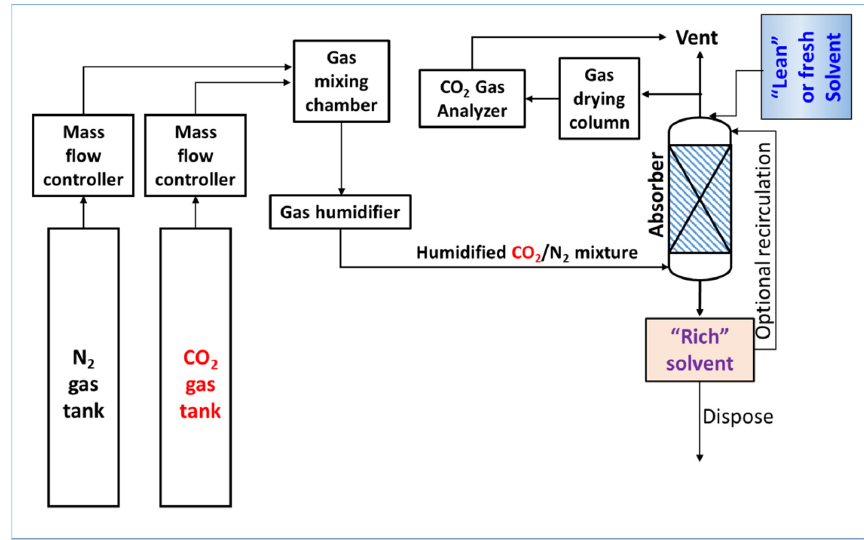
Figure 10. Schematic of the laboratory gas scrubber testing unit operated in single-pass flow-through absorption mode.